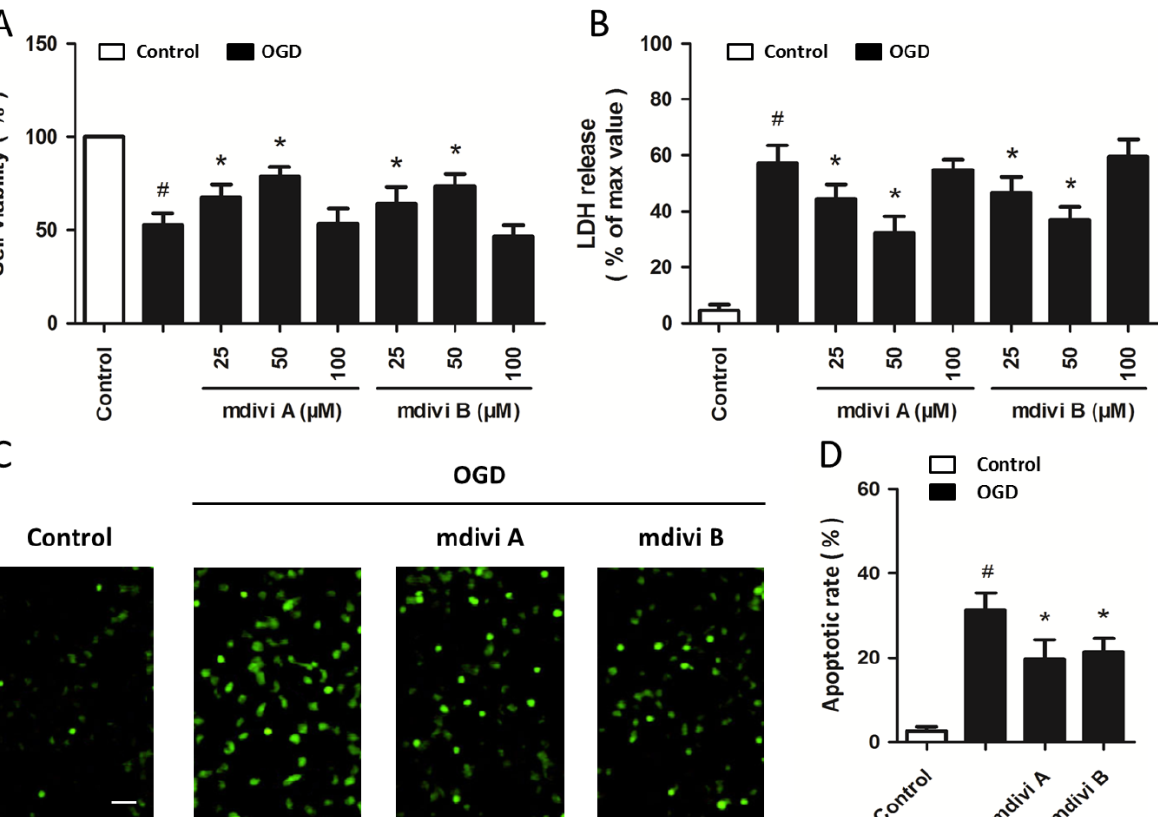
Figure 2. Drp-1 inhibitors reduce ischemic toxicity in PC12 cells. PC12 cells were pretreated with mdivi A or mdivi B at different concentrations (25, 50 or 100 μM) for 30 min before oxygen-glucose deprivation (OGD) injury. Cell viability was measured with the WST assay ( A ); and cytotoxicity was measured with the LDH assay ( B ); PC12 cells were pretreated with mdiviA (50 μM) or mdivi B (50 μM) for 30 min before OGD injury. Apoptotic cell death was detected by TUNEL staining ( C ) and calculated ( D ). Scale bar: 40 μm. The data were represented as means ± SD from five experiments. # p < 0.05 vs. control. * p < 0.05 vs.